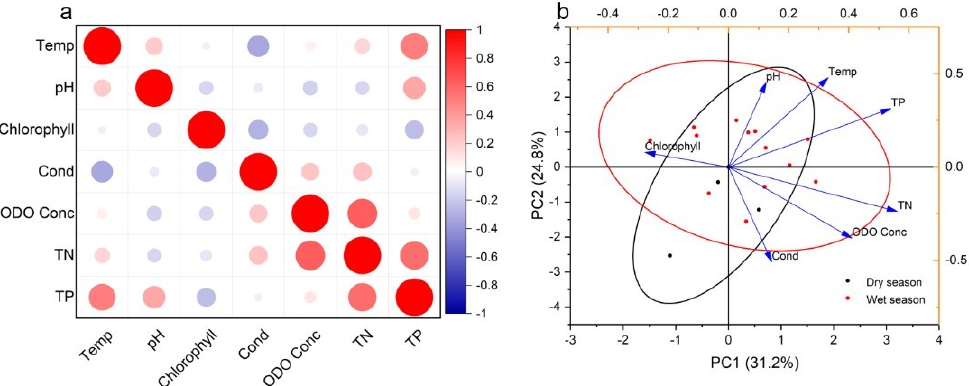
Figure 13. Correlations and principal component analysis of each water parameter in Lake Xingyun. ( a ) Correlations analysis. ( b ) principal component analysis.